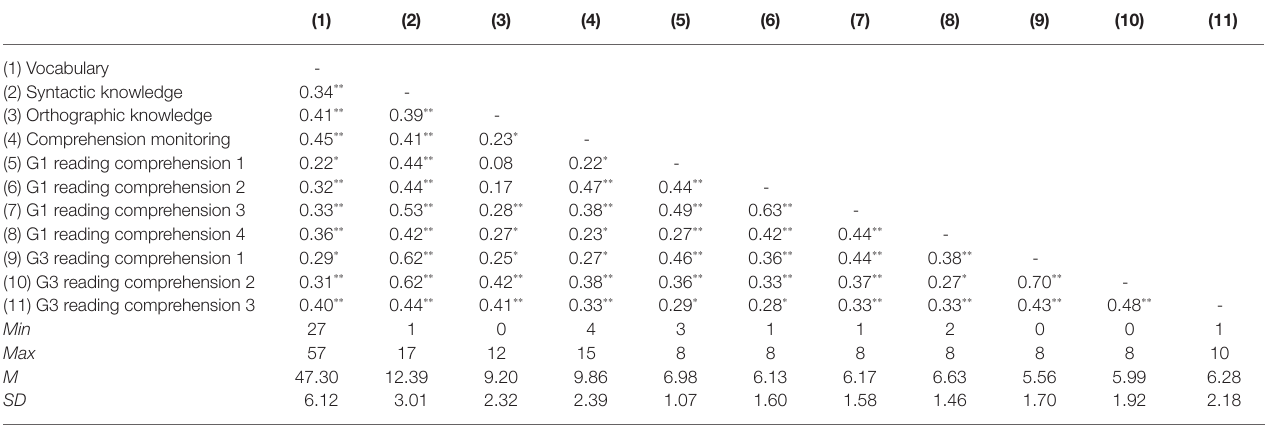
TABLE 1 | Descriptive statistics and bivariate correlations among study